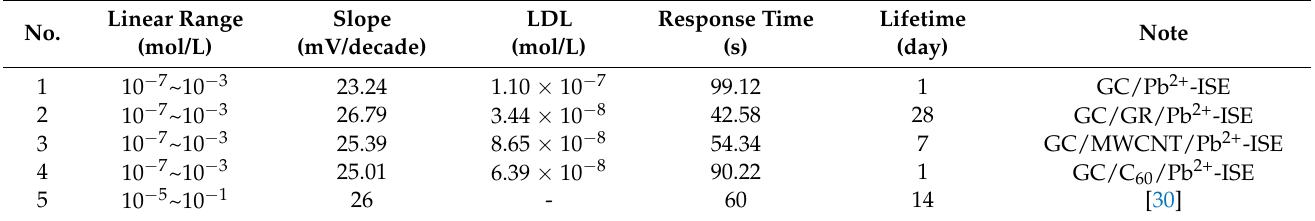
Table 2. Comparison of comprehensive performance for different Pb 2+ electrodes.